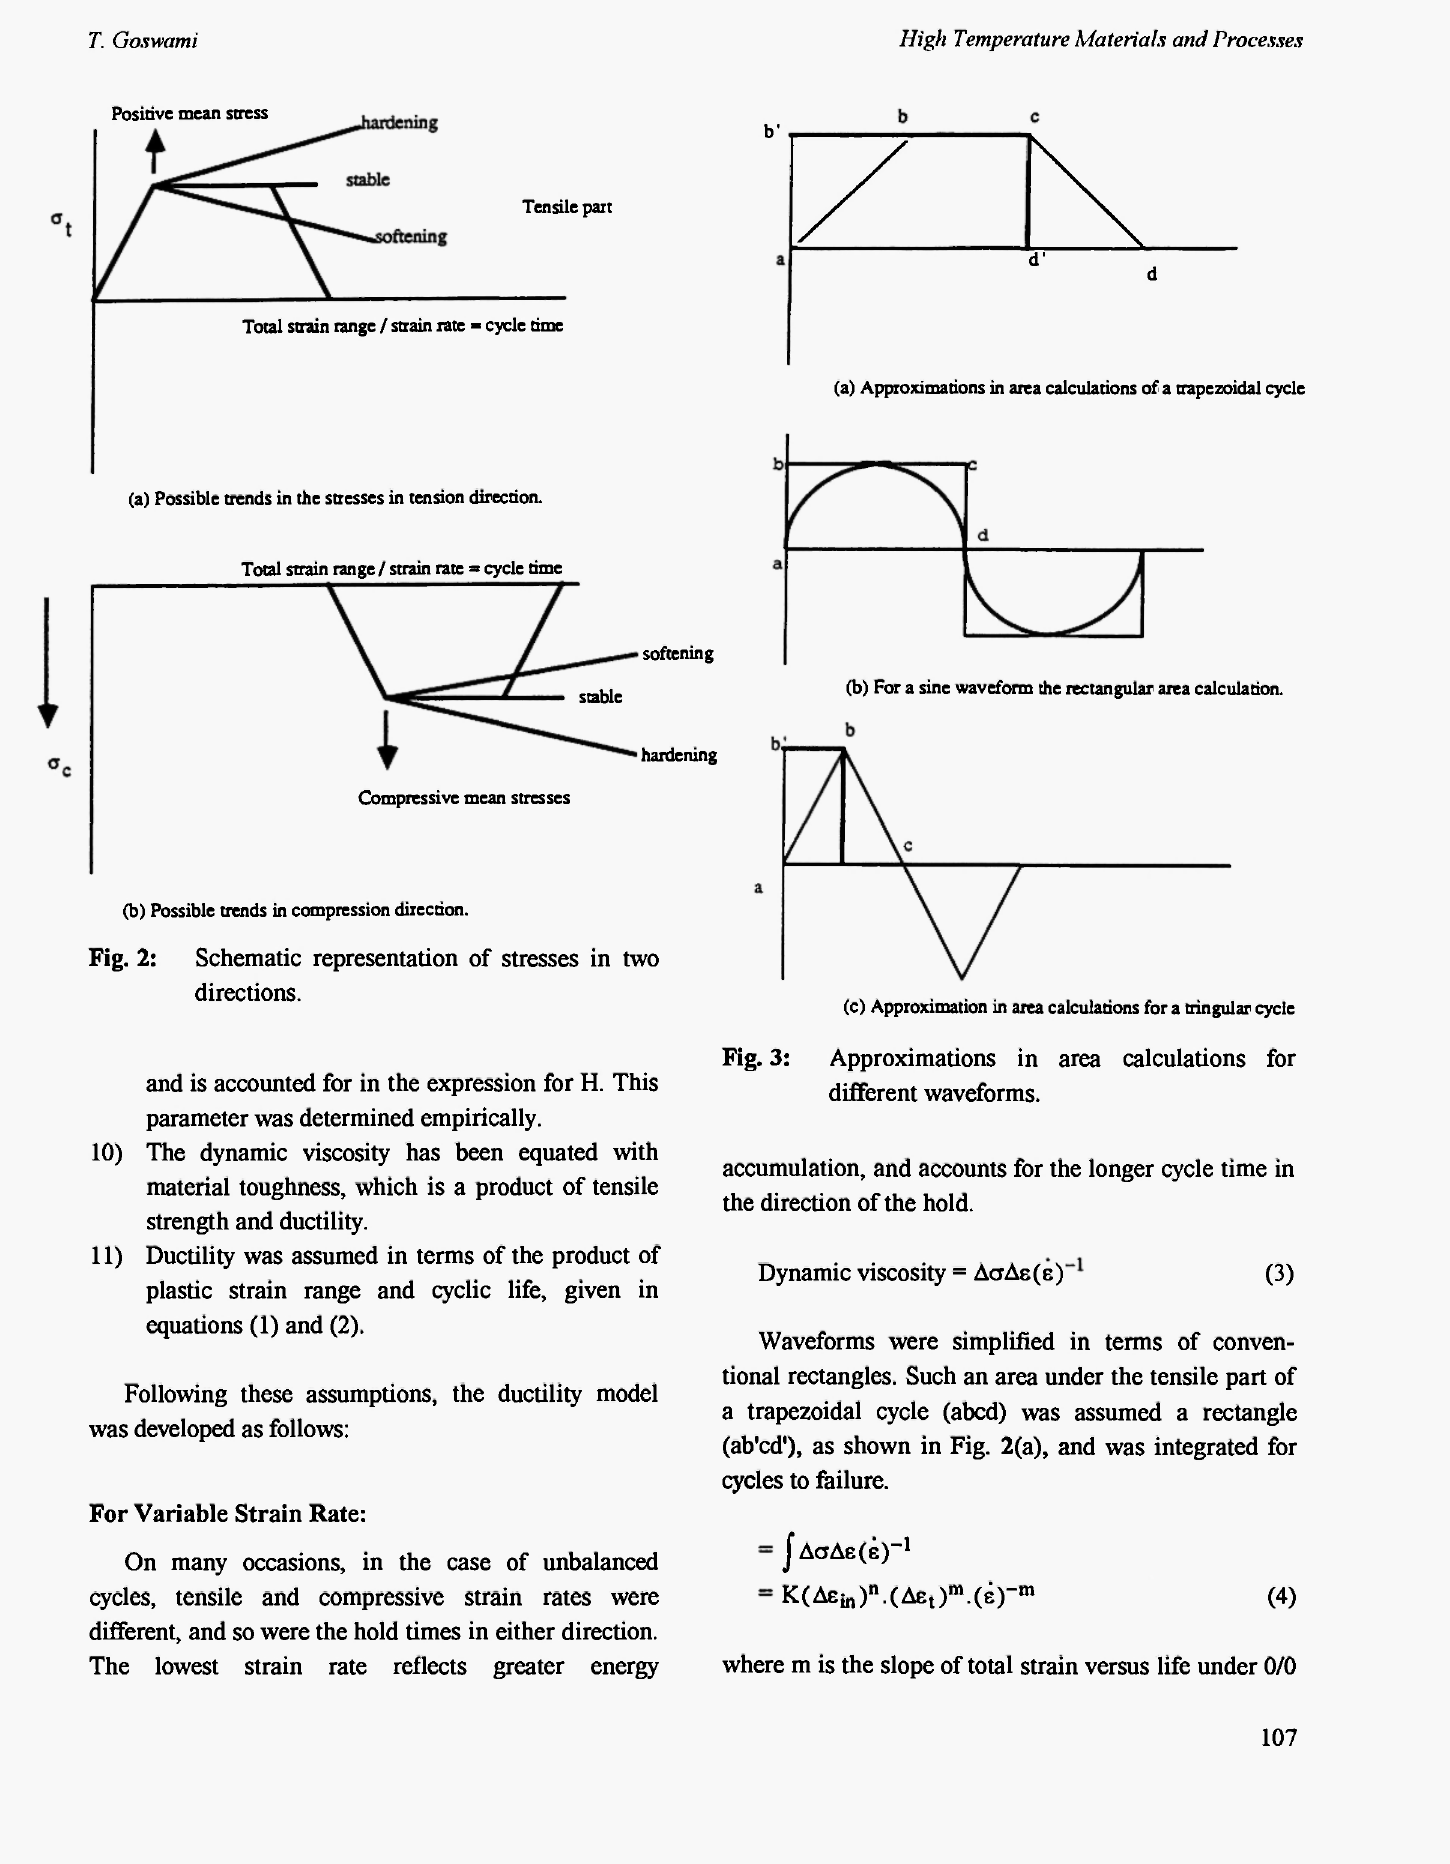
Fig. 3: Approximations in area calculations for different